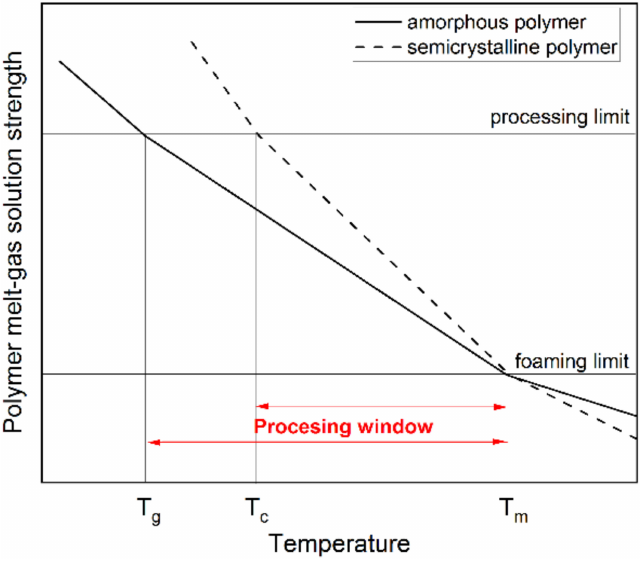
Figure 3. Schematic representation of the foaming processing window for semicrystalline and amorphous polymers, adapted from